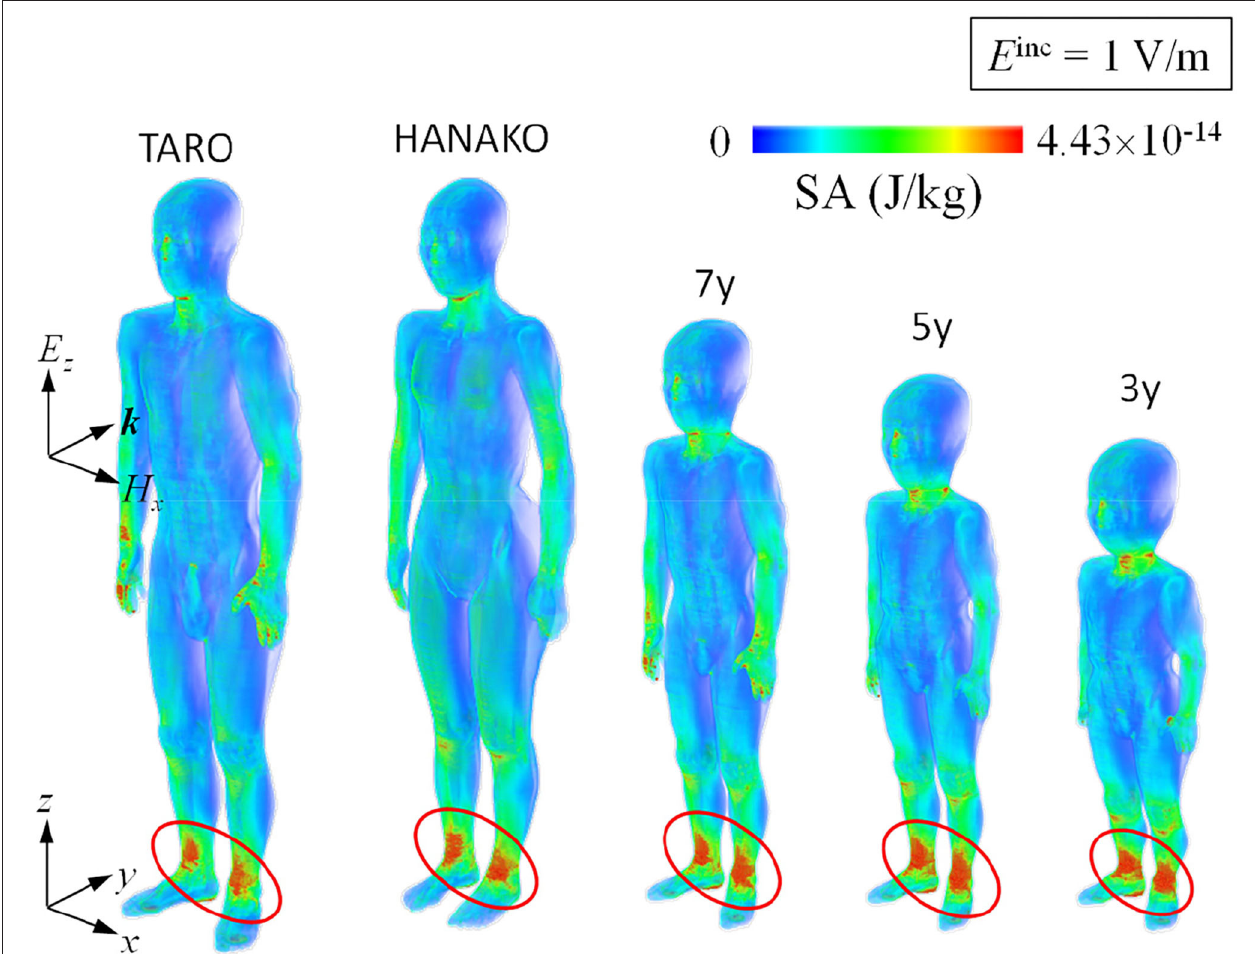
FIGURE 9 | SA distribution for one pulse illumination for various grounded human